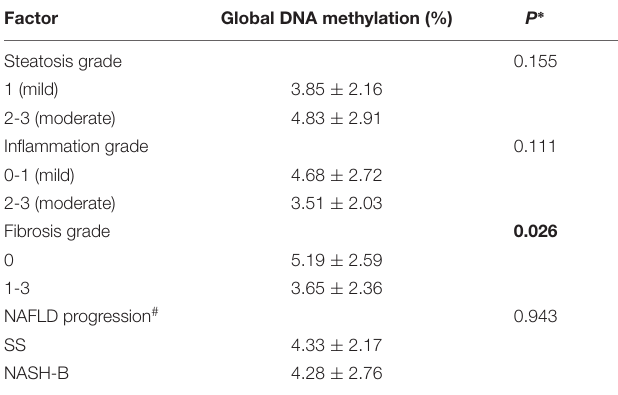
TABLE 2 | Liver pathology of the study population based on the disease status, n (%). Factor